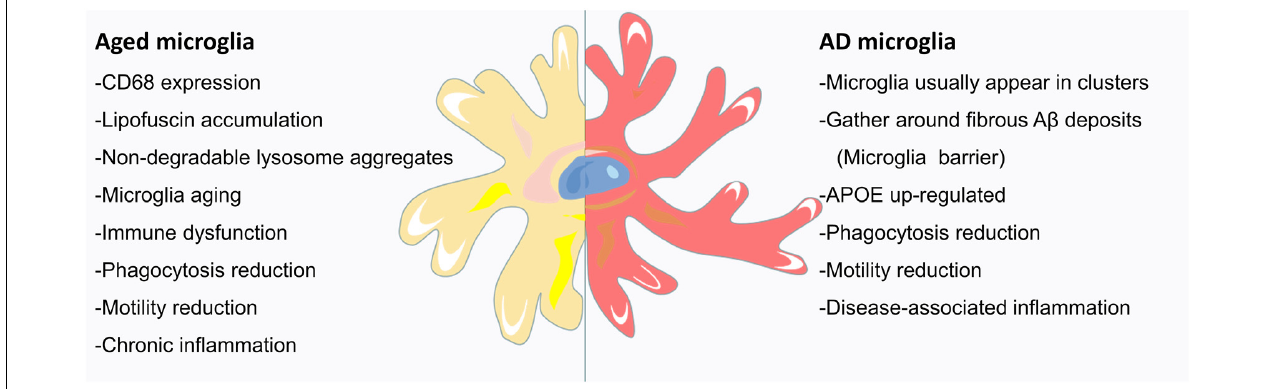
FIGURE 2 | Microglia in the aging AD brain: the signs of aging are an increase in CD68 expression and the accumulation of lipofuscin. Aged mice have large microglia with short, thick dendrites, few branches, signs of malnutrition, and decreased phagocytotic and locomotor abilities. Age-related myelin fragmentation overloads the microglial lysosomal system, and the accumulation of lipids and nondegradable lysosomal aggregates leads to microglial senescence and immune dysfunction. As AD is a disease, closely related to aging, the microglia of the AD brain usually appear in clusters and gather around deposits of A β fibrils (discussed in the following section). With aging, the protruding movement of microglial processes is significantly reduced, and microglial coverage is reduced, leading to an increase in A β fibril hotspots. In addition to the upregulation of APOE, AD microglia also showed enhanced aging characteristics. Microglia respond to brain tissue damage that accumulates in AD and during aging, leading to increased inflammation, further reduction in phagocytic and motor abilities, and neuronal communication